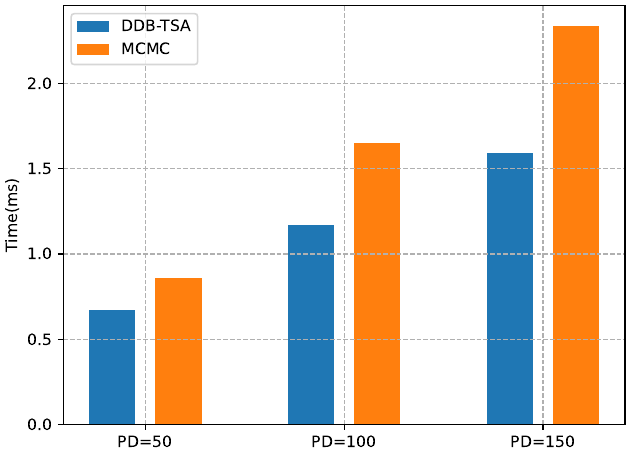
Figure 3. Tip Chosen